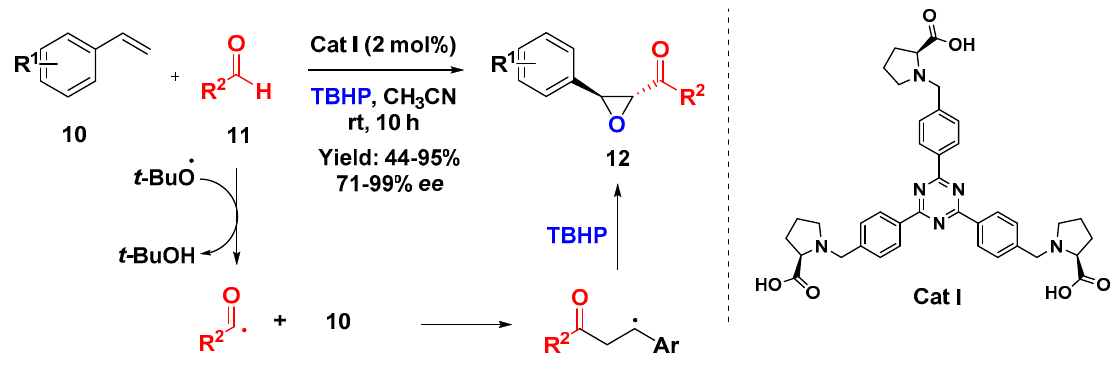
Scheme 3. Proline ‐ based chiral C 3 ‐ symmetric organocatalyst for the synthesis of epoxide derivatives through a domino reaction.